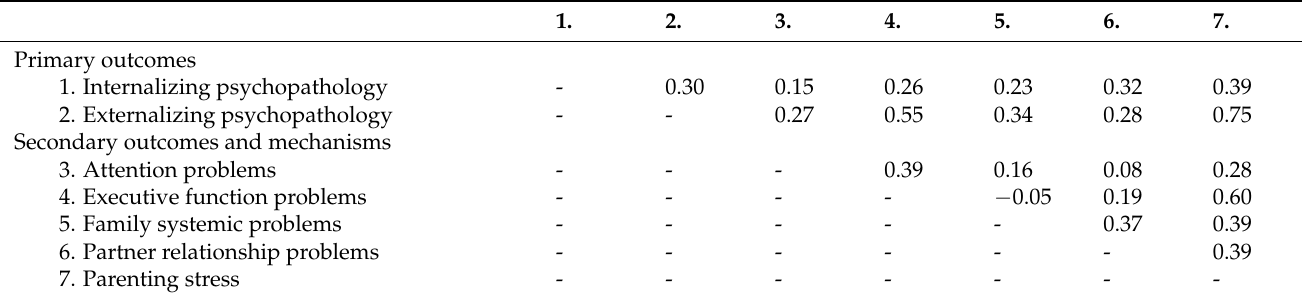
Table 4. Correlations between all outcome measures.